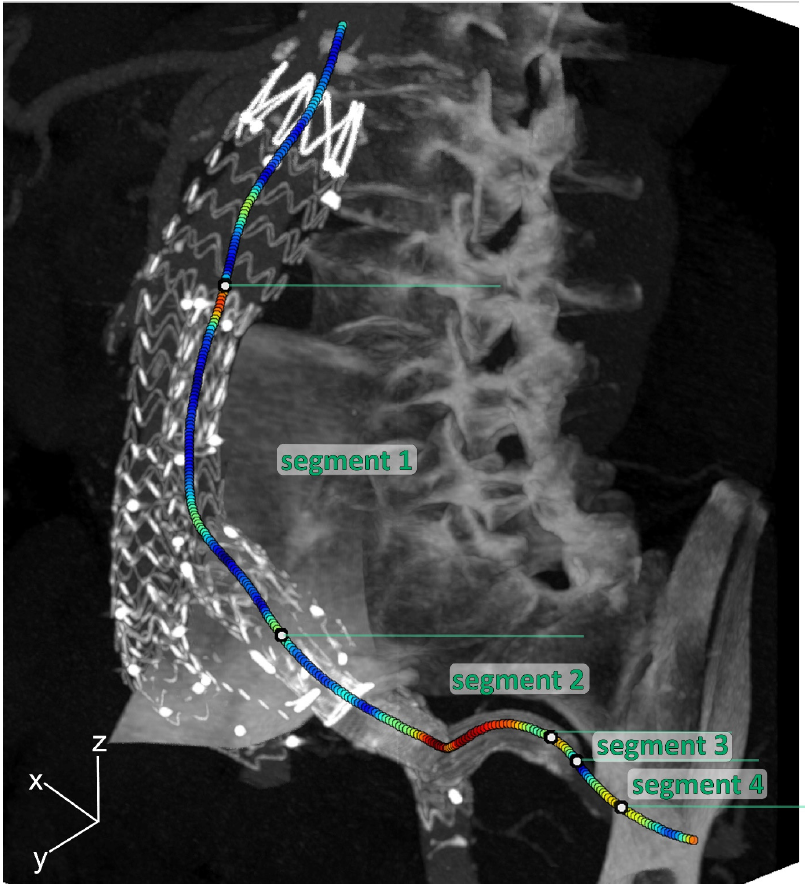
Figure 2. Three-dimensional maximal intensity projection of the mid-cardiac cycle volume example, including curvature color-coded centerlines (red is high curvature; blue is low curvature) for the internal iliac artery (IIA), which was divided into 4 segments: Segment 1: main EVAR flow divider—IBD flow divider; Segment 2: IBD bifurcation—5 mm upstream of the end of the IIA component; Segment 3: 5 mm upstream of the end of the IIA component—5 mm downstream of the end of the IIA component; Segment 4: 5 mm downstream of the end of the IIA component—first native IIA bifurcation.